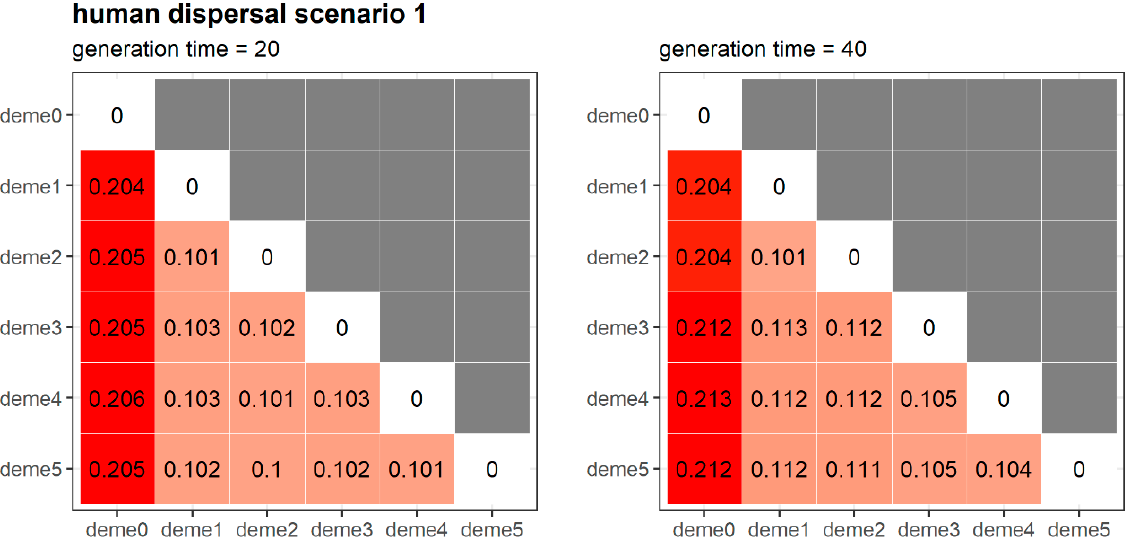
Figure A4. The mean pairwise Fst values calculated across 100 replicate simulations of a post- megafauna Indigenous-mediated dispersal scenario (“hd1” in Table A1). This scenario of Indigenous dispersal assumes a symmetric island model of migration between all demes from 5000–200 years ago.